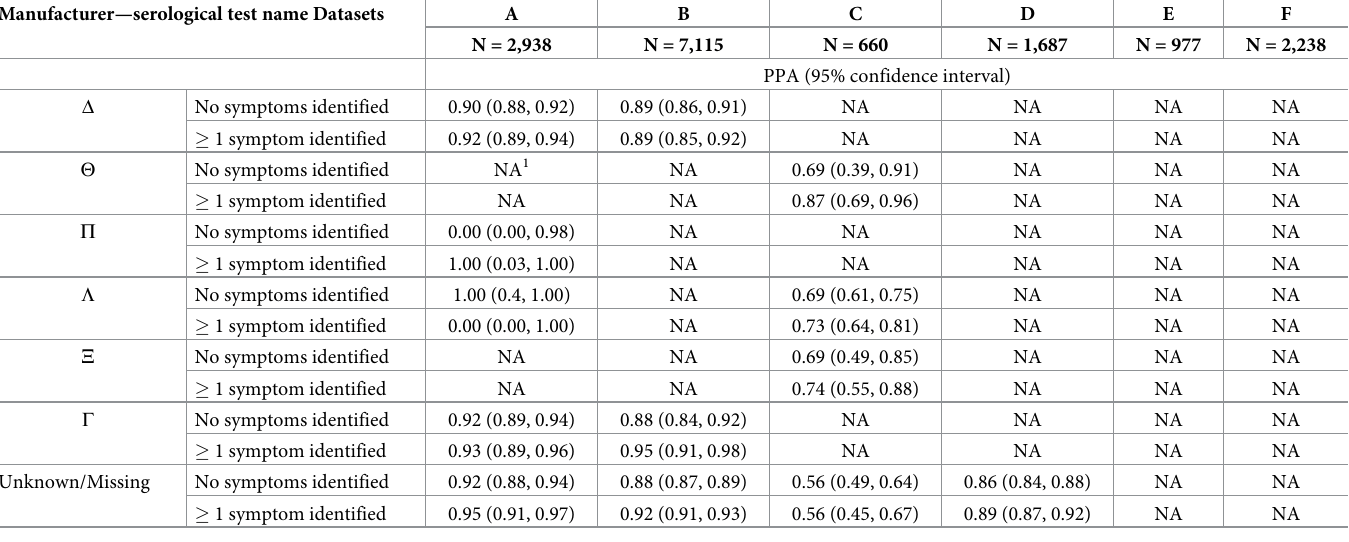
Table 3. Positive percent agreement (PPA) by serology tests and presence of symptoms. Manufacturer—serological test name Datasets